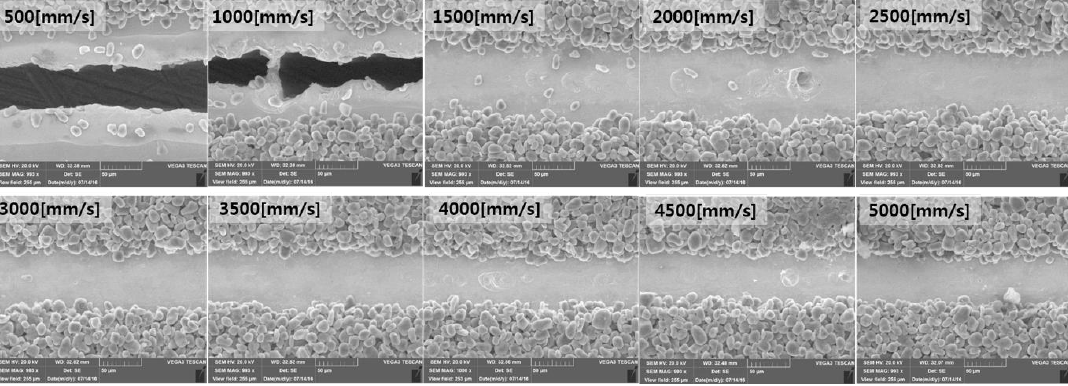
Figure 10. SEM images with a laser power of 150 W.